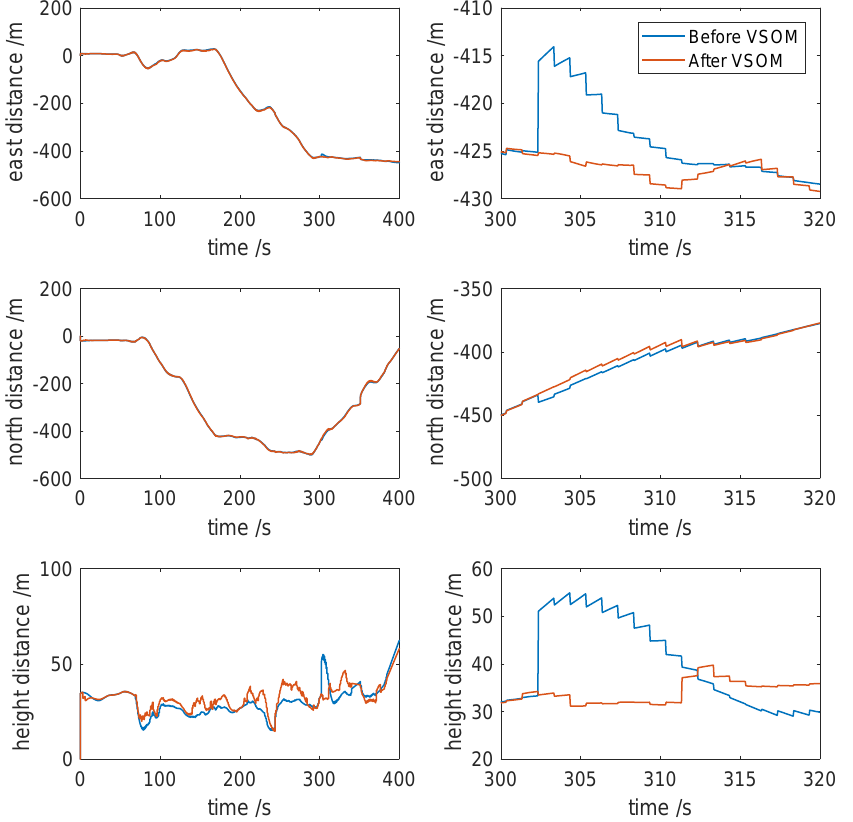
Figure 8. Distance from initial position to the current position. ( left ) Overview. ( right ) An in-depth look at the